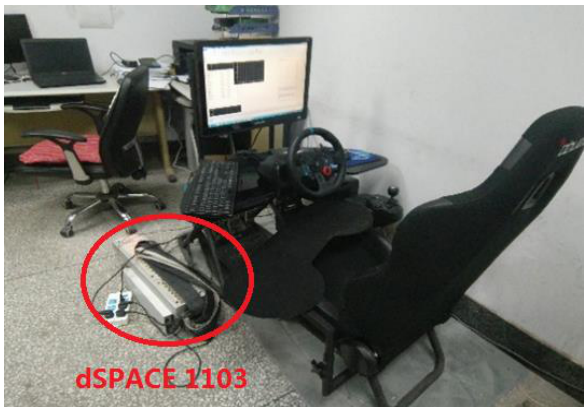
Figure 13. Testing simulator platform based on dSPACE hardware.